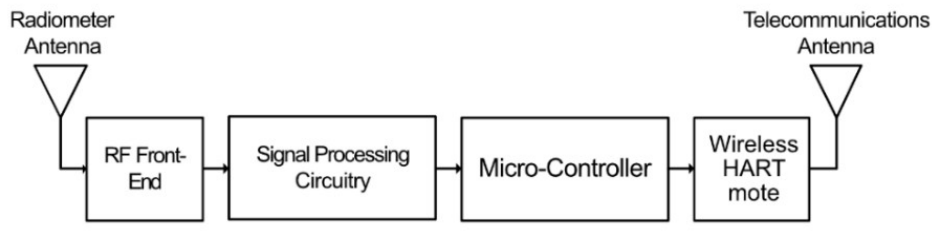
Figure 11. Block diagram of the sensor node of the PD detection system [74].